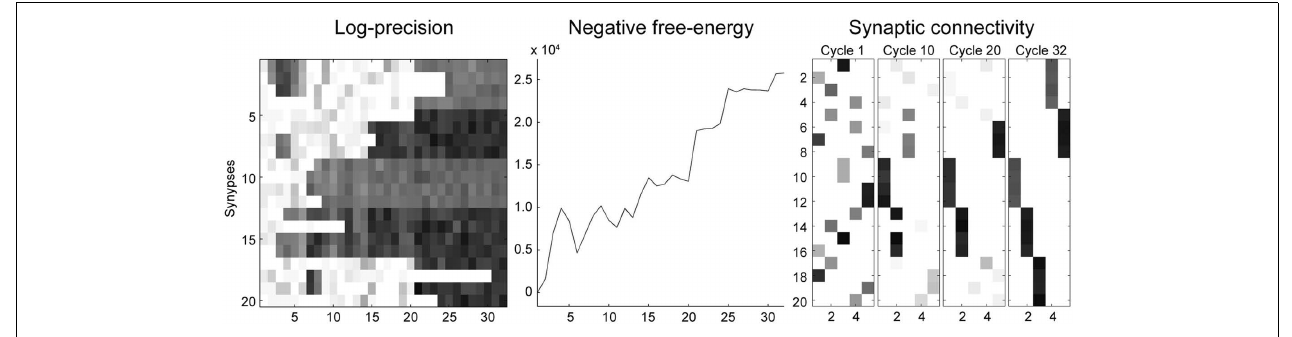
negative free energy. In most iterations, the free-energy decreases but there are sporadic setbacks: e.g., after the sixth iteration.This is due to the stochastic search, i.e., the random sampling of presynaptic axons. (Right panel): Snapshots of the connectivity matrix W (see Materials and Methods) after iterations 1, 10, 20, and